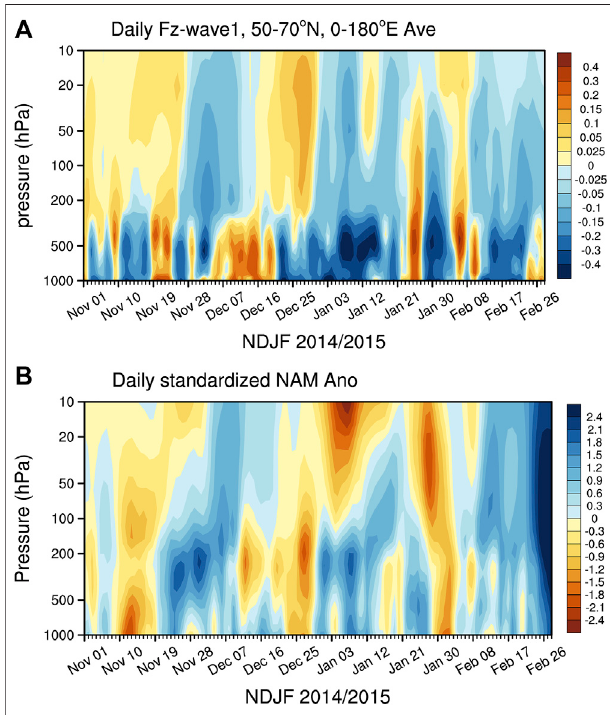
FIGURE 6 | Pressure – time cross-section of (A) vertical wavenumber-1 activity fl ux (unit: 10 – 1 m 2 s − 2 ) averaged in the domain (50 ° – 70 ° N, 0 ° – 180 ° E), and (B) standardized NAM anomalies in winter